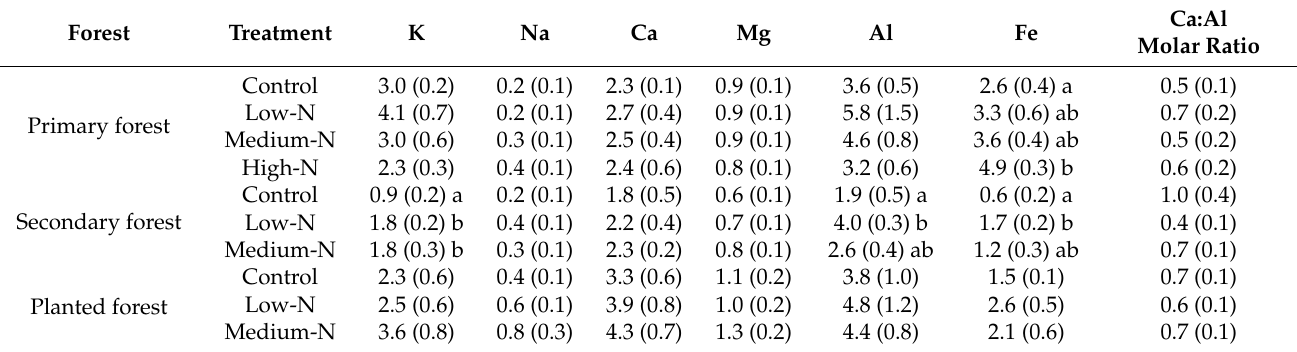
Table 2. Fine root K, Na, Ca, Mg, Al, and Fe concentrations and Ca:Al molar ratio. Unit is mg g − 1 fine root dry mass. Different lower case letters indicate significant difference between treatments in each forest (One-way ANOVA, LSD test, p < 0.05).